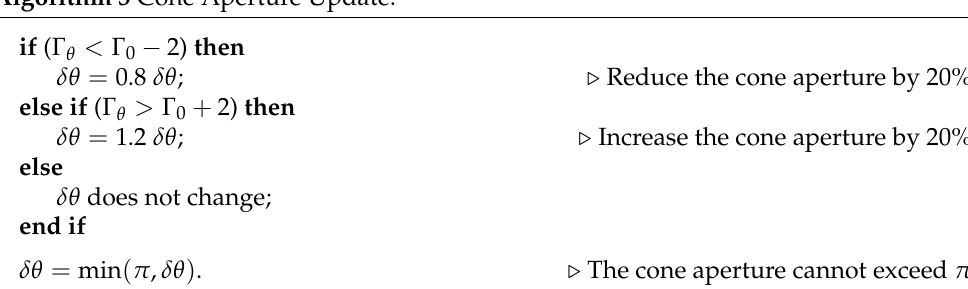
Algorithm 3 Cone Aperture